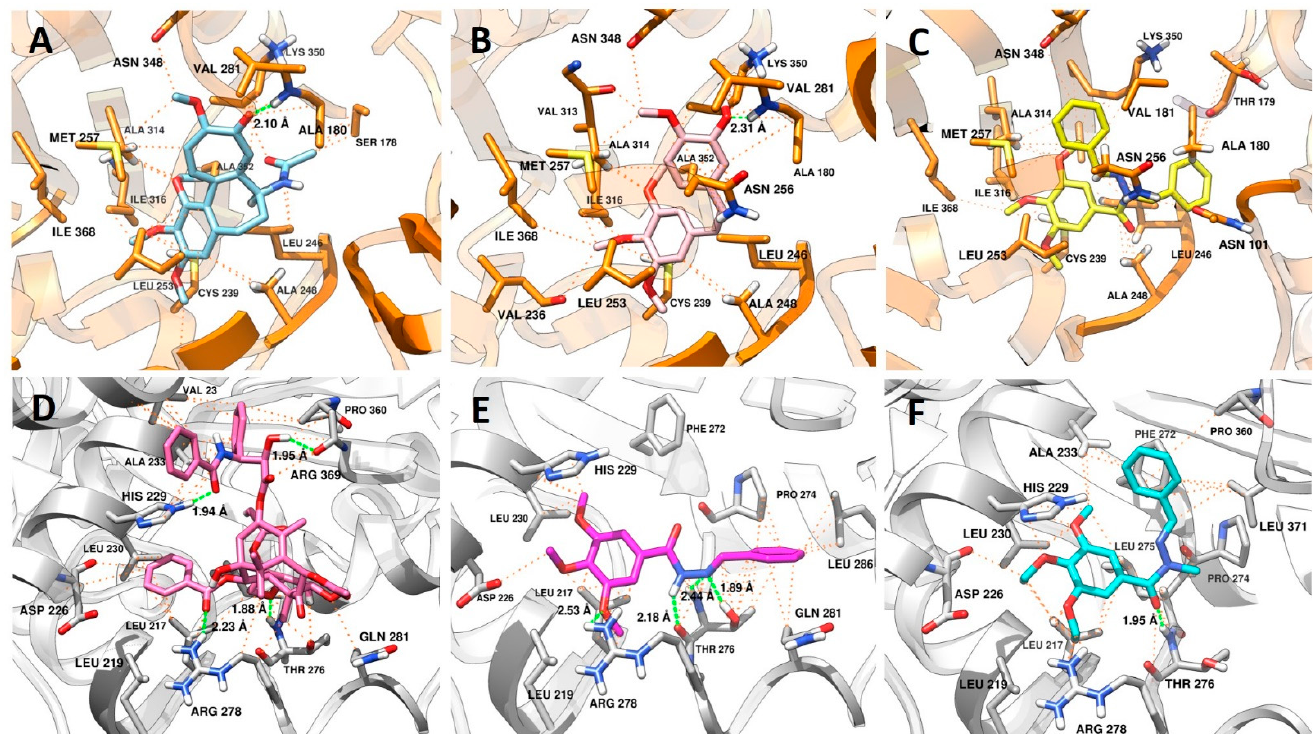
Figure 6. Analysis of the interaction mode in ( A ) colchicine in sky blue; ( B ) CA4 in pink; and ( C ) LASSBio-2070 ( 11 ) in yellow at the colchicine binding site (PDB: 5XIW). Protein carbon atoms are represented in orange, oxygen in red, nitrogen in blue and the distances between hydrogen bonds are represented by the green line. Hydrophobic interactions are represented by orange lines. Analysis of the interaction mode in ( D ) taxol in hot pink; ( E ) LASSBio-1586 ( 3 ) in magenta; ( F ) and LASSBio-1735 ( 3 ) in cyan at the taxol binding site (PDB: 6WVR). Protein carbon atoms are represented in gray, oxygen in red, nitrogen in blue and the distances between hydrogen bonds are represented by the green line. Hydrophobic interactions are represented by orange lines.